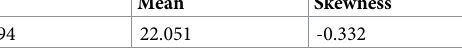
Various existing lifetime distributions like exponentiated exponential, exponential, Weibull, exponential Weibull, alpha power inverted exponential, and new flexible exponential distribu- tion were compared with the proposed distribution. Theoretical and experimental graphs